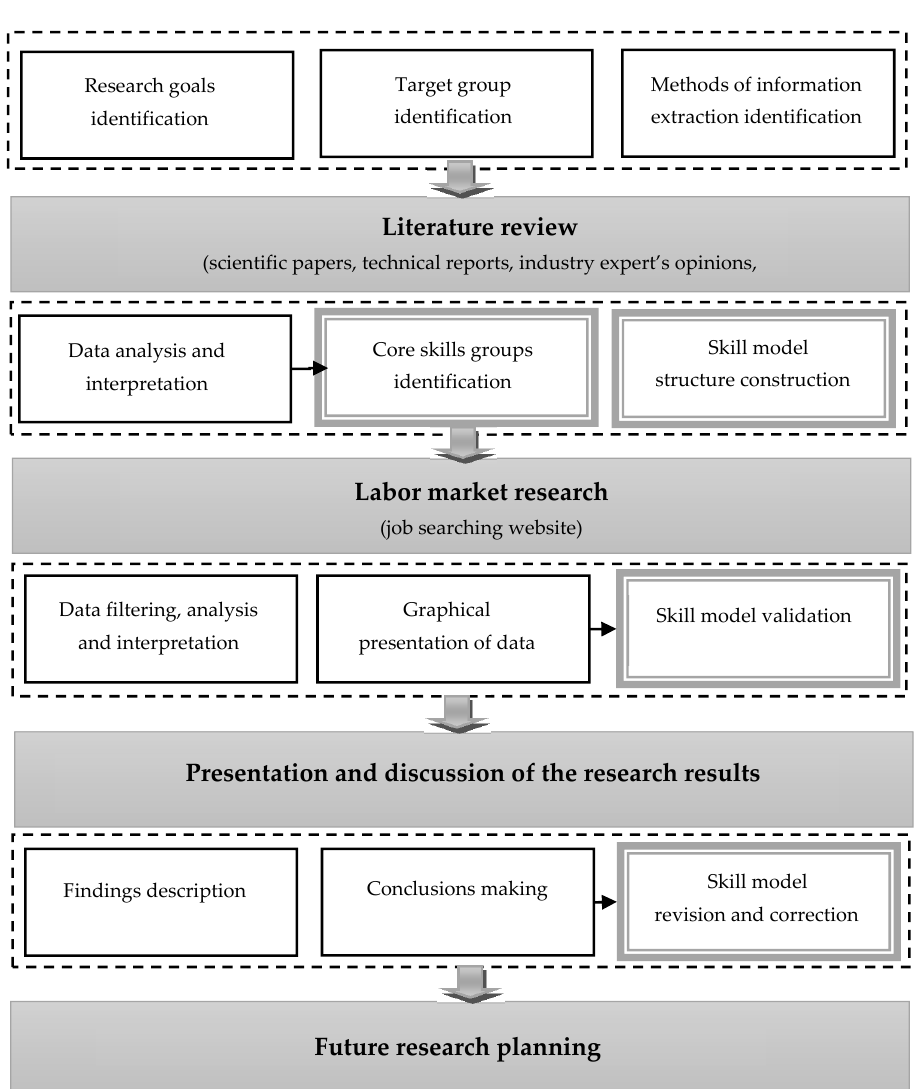
Figure 1. The research framework.